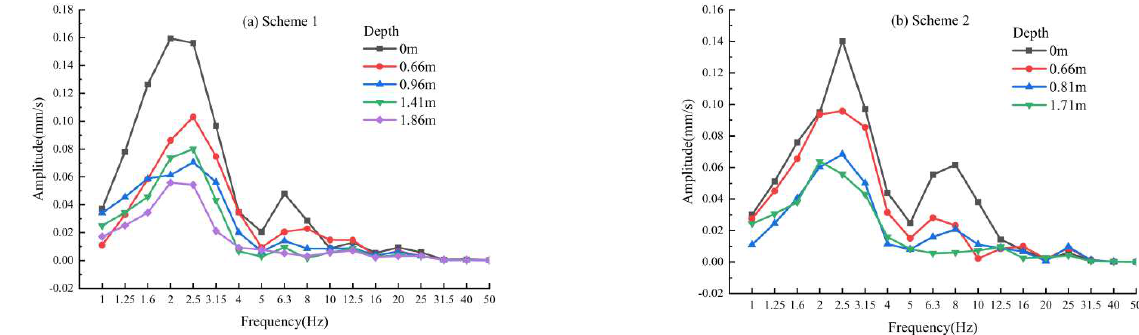
Appl. Sci. 2023 , 13 , 864 Figure 11. One-third frequency range analysis of the longitudinal decay curve. Figure 11. One-third frequency range analysis of the longitudinal decay curve.